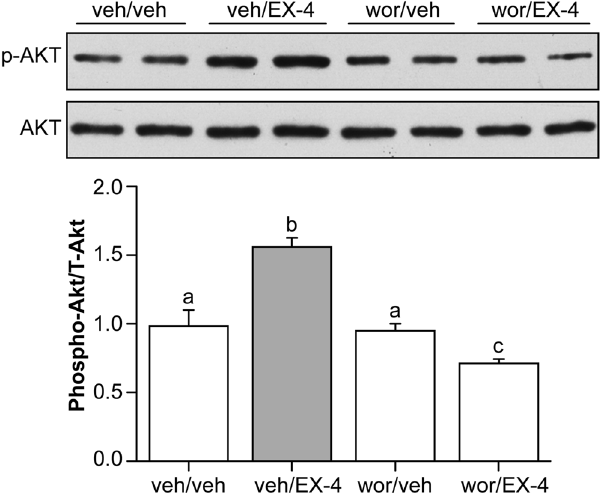
Figure 3. Activity of PI3K/AKT in the arcuate nucleus. EX-4 robustly increased phosphorylation of AKT in the ARC, and wortmannin inhibited this increase. In each panel, groups that share the same letter are not significantly different from each other after obtaining a significant main effect by two-way ANOVA. veh/veh: vehicle (5% DMSO in aCSF) third ICV and vehicle (water) IP; veh/EX-4: vehicle (5% DMSO in aCSF) third ICV and EX-4 IP; wor/veh: wortmannin third ICV and vehicle (water) IP; wor/EX-4: wortmannin third ICV and EX-4 IP.